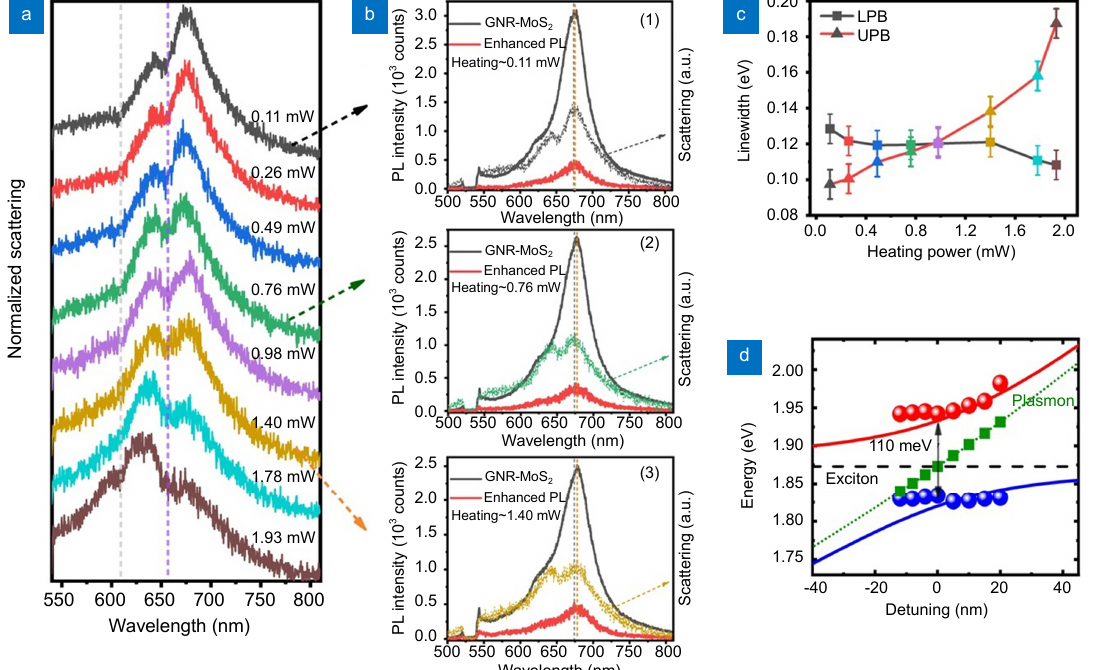
Fig. 4 | Plasmon exciton interaction in the GNR-MoS 2 hybrid. ( a ) Scattering spectra of individual GNR coupled to the monolayer MoS 2 flake.